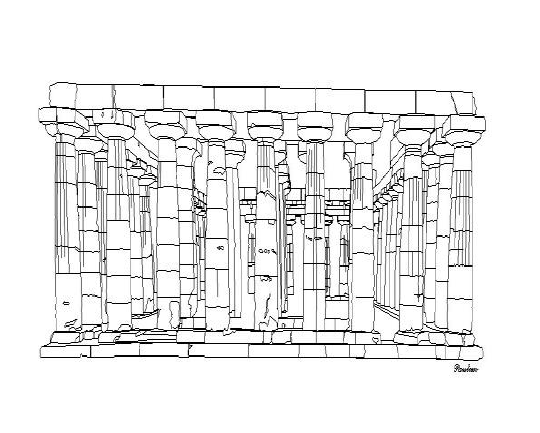
Figure 9. Axonometry Hera Argiva’s Temple in Paestum